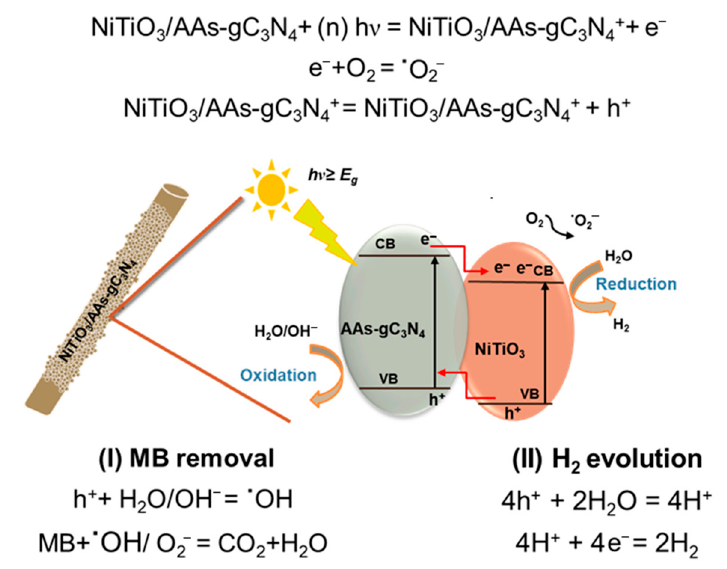
Figure 9. Proposed mechanism of photogeneration and transport of charge carriers at the interface of the NiTiO 3 NFs and AAs-gC 3 N 4 heterostructures.